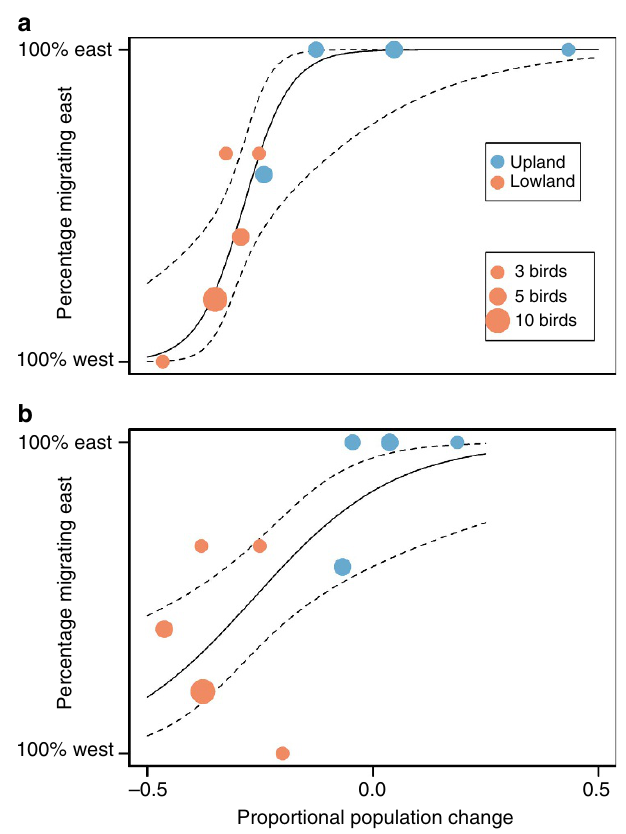
Figure 3 | Relationship between migration route use and population change across nine tagging locations. Results are shown for ( a ) Atlas and ( b ) BBS cuckoo population change data sets and are based on events/trials logistic regressions where the migration directions of individual birds tagged in each locality are predicted by population change variables (see Methods). The modelled effect of migration route is shown by the solid line and its 95% confidence intervals by the dotted lines. The relationship was highly significant for both data sets (events/trials logistic regression; Atlas: df 1, w 2 22.7, P o 0.0001; BBS: df 1, w 2 12.0, P ¼ 0.0005). When controlling for the upland/lowland habitat division (see Methods for definition), the relationship remained highly significant for the Atlas data set events/trials logistic regression; (df 1, w 2 8.7, P o 0.0031) but not for the BBS data set (events/trials logistic regression; df 1, w 2 0.0, P ¼ 0.842). Atlas population change data are from surveys of 39,936 2km 2 in 1998–91 and 45,374 in 2007–11. BBS data set population change was based on surveys of up to 3,018 1km 2 each year between 1994–96 and 2007–11, requiring interpolation to give national coverage, and is therefore less robust for assessing local population changes. Habitat classification, migration route and population change data for each tagging location are shown in Supplementary Table pressing concern of migratory land-bird conservation 1,4,5,30,32 , as well as the provision of important opportunities for raising awareness of these declines among the public 14 .